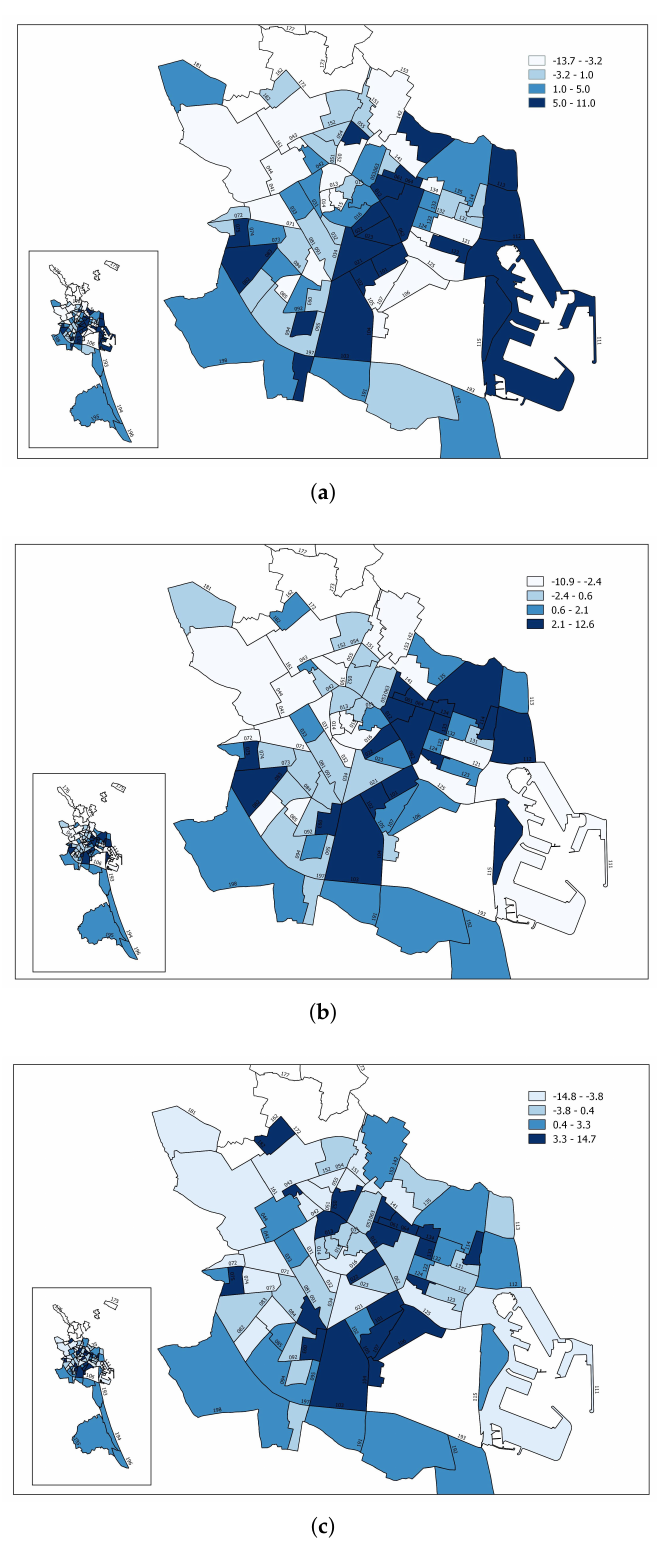
Figure 2. Mixed model. Consumption differences (percentages in relation to the average). Neigh- bourhoods for ( a ) P = 2, ( b ) P = 3 and ( c ) P =